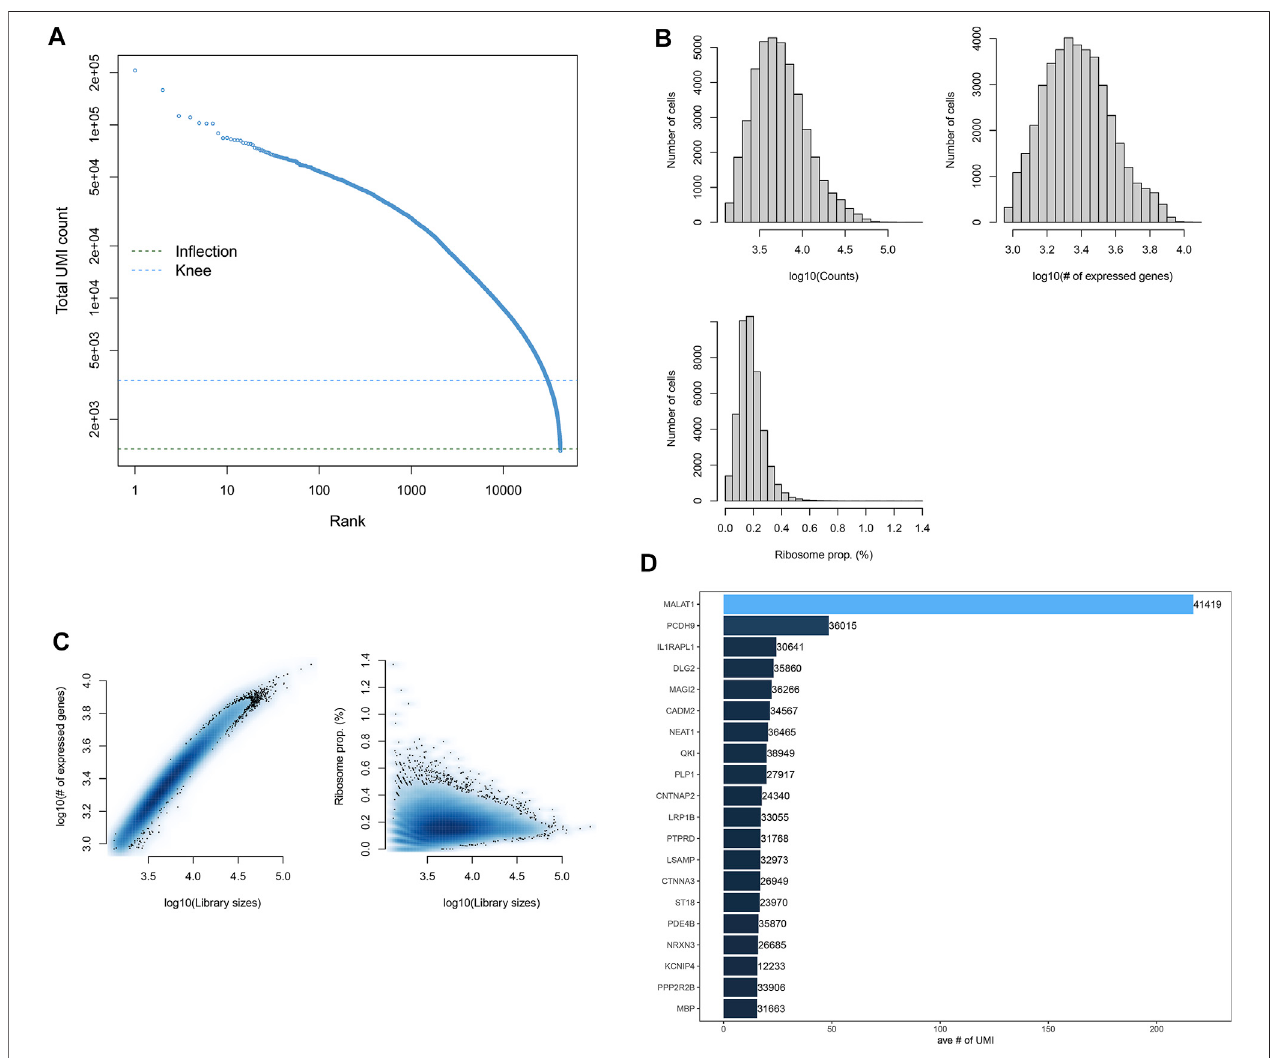
FIGURE 1 | Quality control and preprocessing of scRNA-seq. (A) Ranking of cells according to the total UMI count. (B) Number of cells that expressed genes. (C) Ratio of ribosomal genes expressed in each cell after fi ltering out cells with < 100 expressed genes. (D) Top 20 genes expressing more